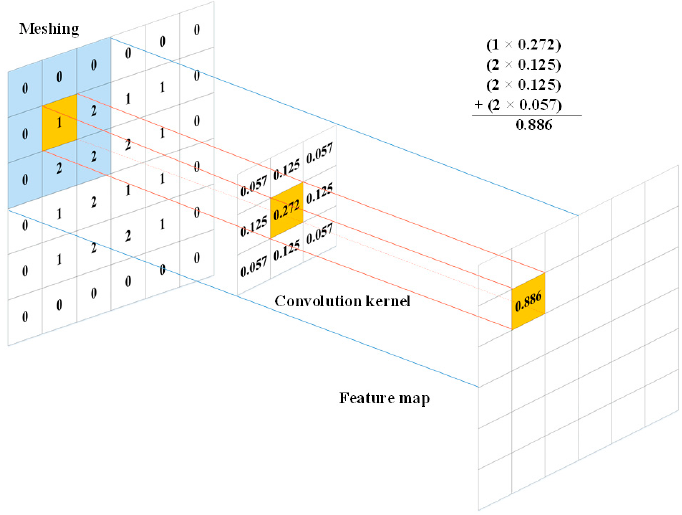
Figure 2. The schematic diagram of Gaussian kernel convolution operation.